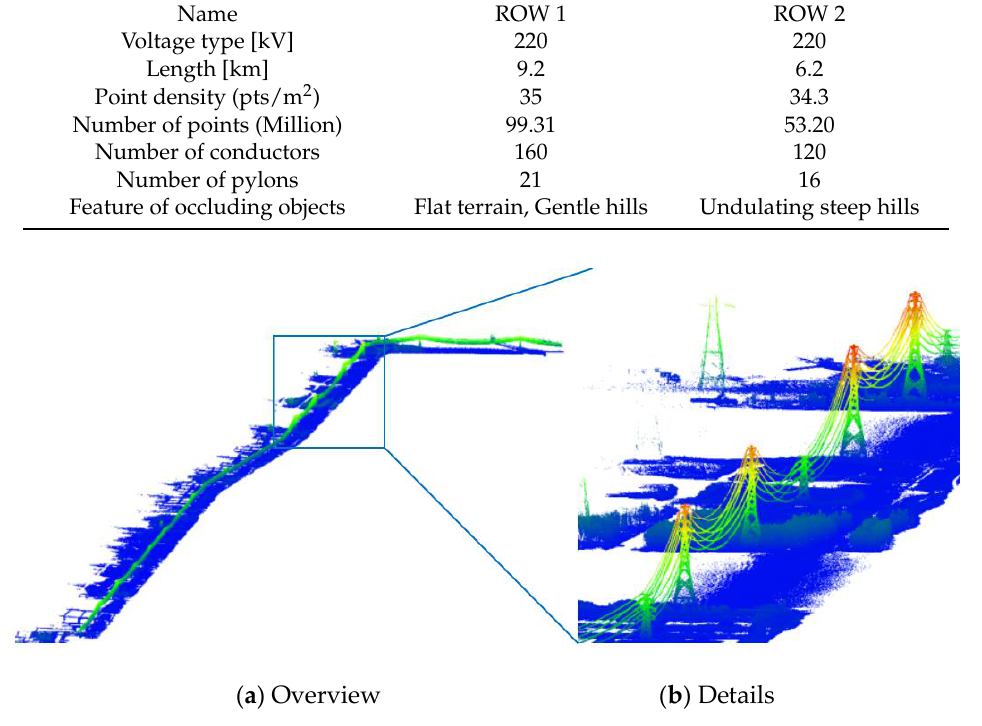
Figure 8. Raw ROW 1 point clouds (rendered with height).